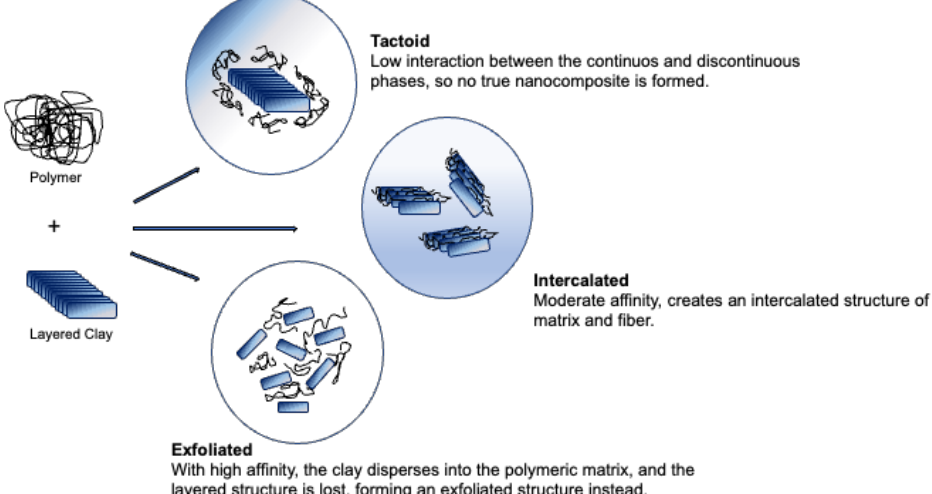
Figure 8. Structures of polymer nanoclay composite.